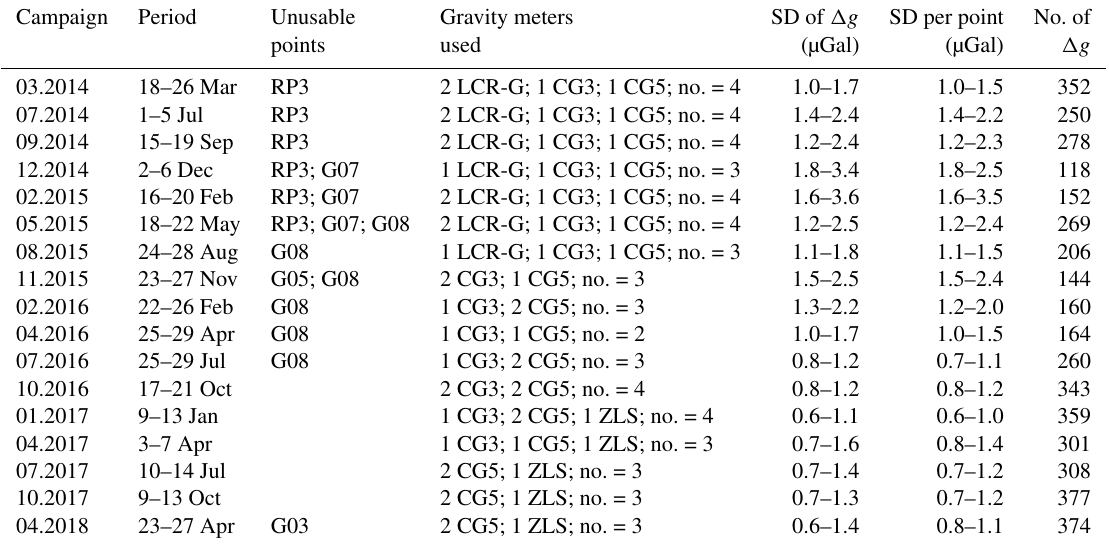
Table 2. Abstract of time-lapse gravimetric field campaigns. Shown are the dates of the campaigns, unusable gravity points, the gravity meters used for the observations per campaign (instruments are LaCoste&Romberg G-Type: LCR-G, Scintrex: CG3 and CG5, ZLS Burris: ZLS), and their number (no.). Furthermore shown are the standard deviations of adjusted gravity differences (SD of (cid:49)g ), the standard deviations of gravity values on measurement points (SD per point), and the total number of adjusted gravity differences (no. of (cid:49)g ) per